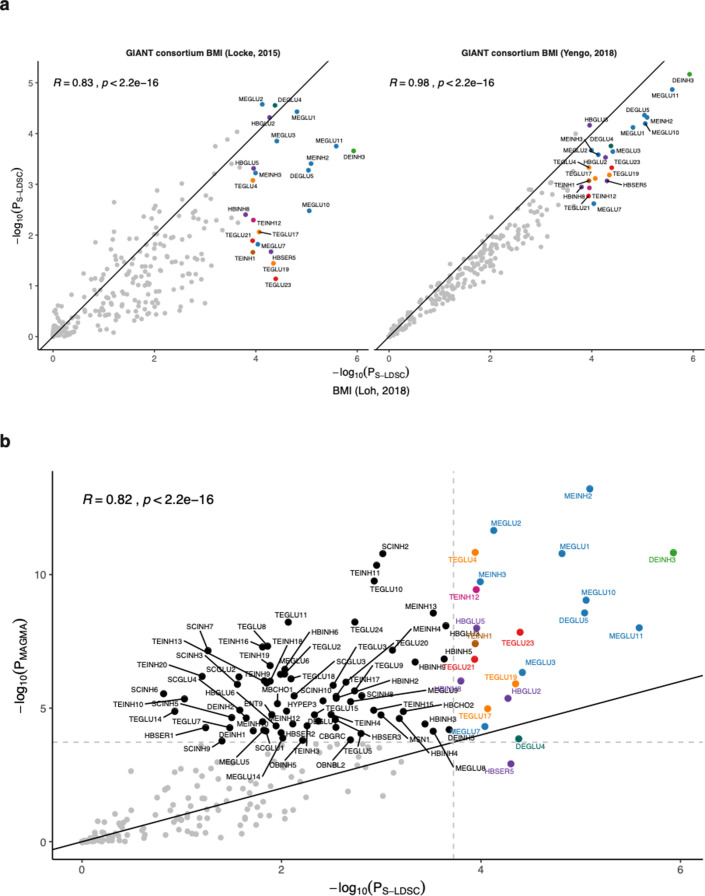
Robustness of cell type prioritization results.(a) Comparison of Mouse Nervous System cell type prioritization results between the primary BMI analysis (Loh et al., 2018 GWAS summary statistics) and the Locke et al., 2015 GWAS summary statistics (sample size >320,000; left plot) and Yengo et al., 2018 BMI GWAS summary statistics (sample size >680,000; right plot). Pearson’s correlation (R) is shown in the top left corner. Solid line shows x = y. (b) Comparison of Mouse Nervous System cell type BMI prioritization results obtained using MAGMA (y-axis) and S-LDSC (x-axis). Pearson’s correlation (R) is shown in the top left corner. Solid line show x = y. Dashed lines highlight cell types passing the Bonferroni significance threshold. MAGMA results are available in Figure 3—source data 7.